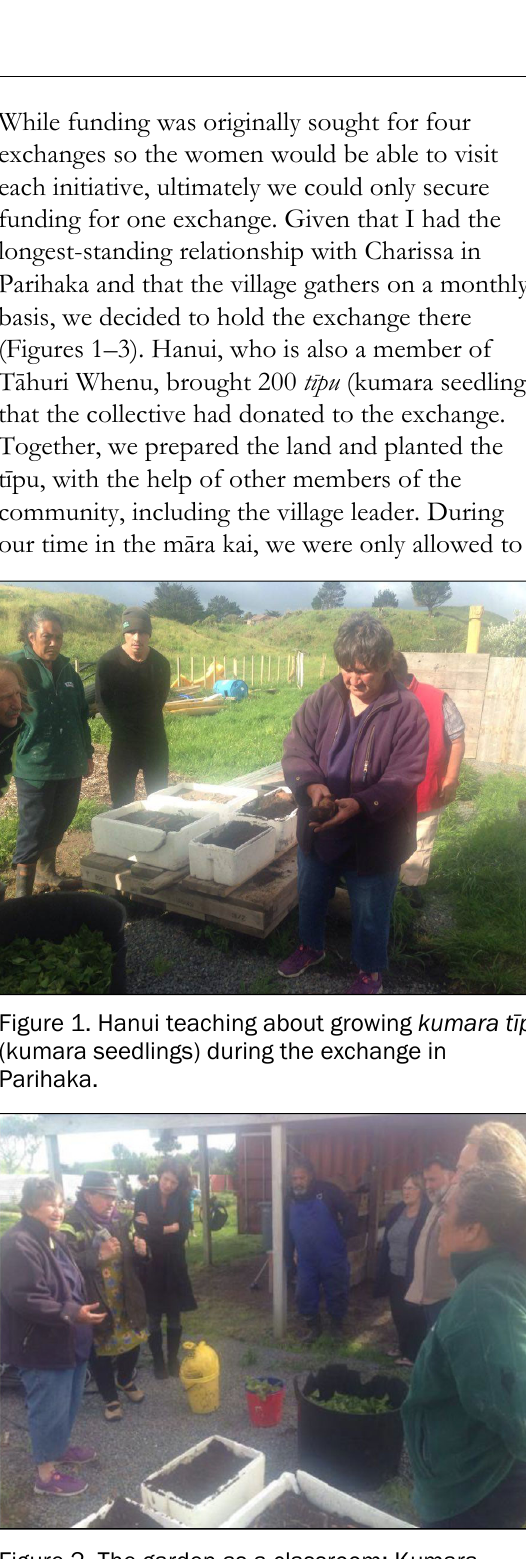
Figure 2. The garden as a classroom: Kumara workshop conducted as part of the Parihaka exchange.